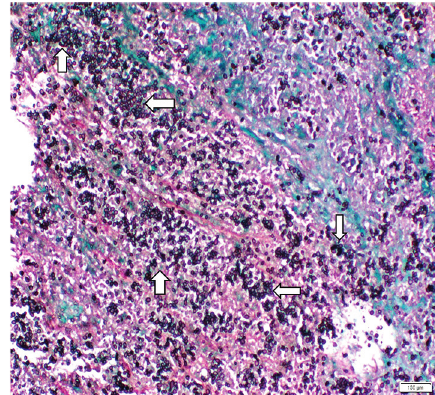
Figure 2: Gomori methenamine silver (GMS) stained adrenal biopsy specimen. Some of the fungal spore clusters are shown with white arrows.